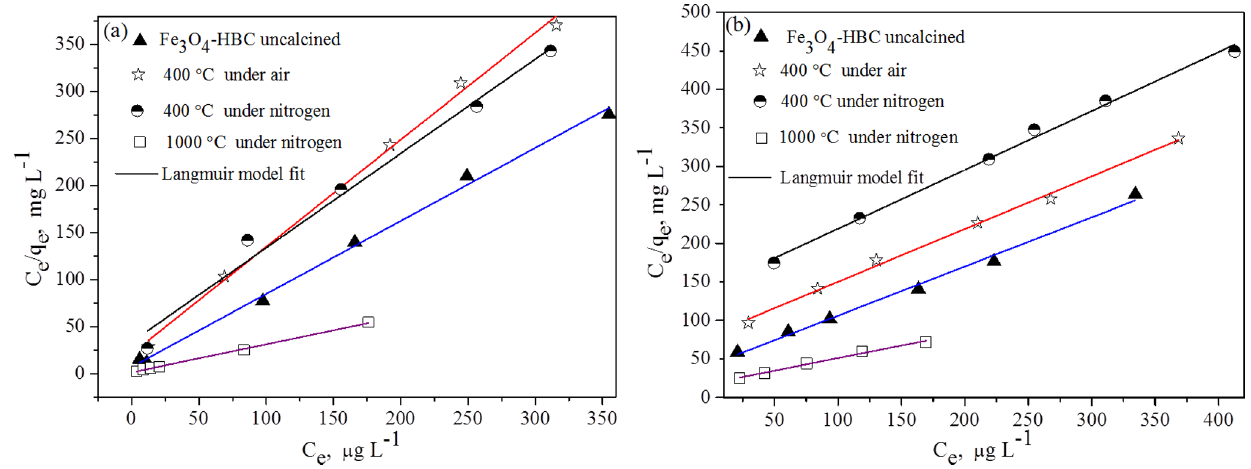
Figure 6. Adsorption isotherm parameters for As(V) (a) and As(III) (b) adsorption onto calcined and uncalcined Fe 3 O 4 -HBC composite at pH 7.0 and temperature (25 ± 0.8 6 C).